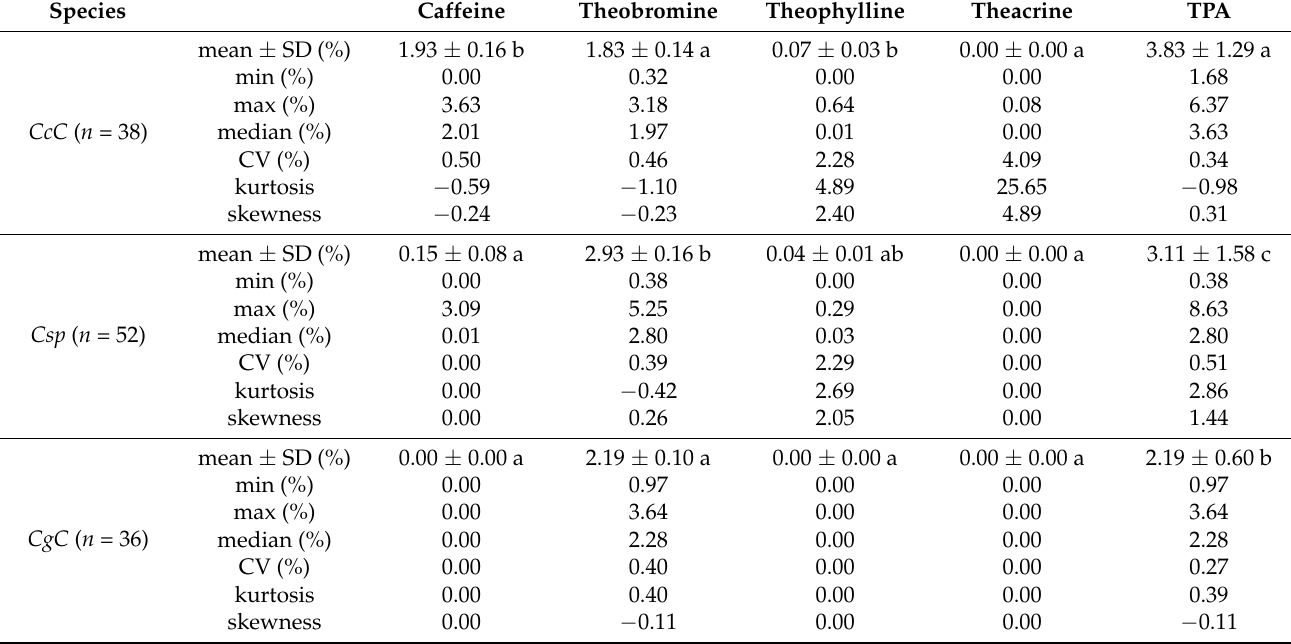
Table 3. Variation and distribution of purine alkaloids in three Camellia species.